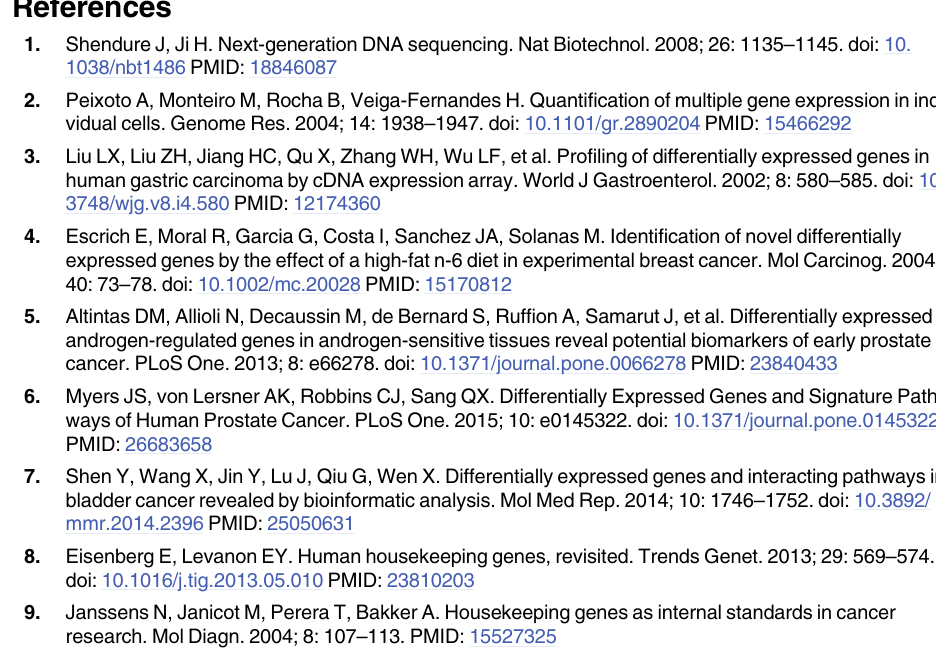
S7 Table. Significant KEGG pathways identified with cutoff criteria of expression changes of (cid:20) 5-fold and with exclusion of the single highest and single lowest expressed